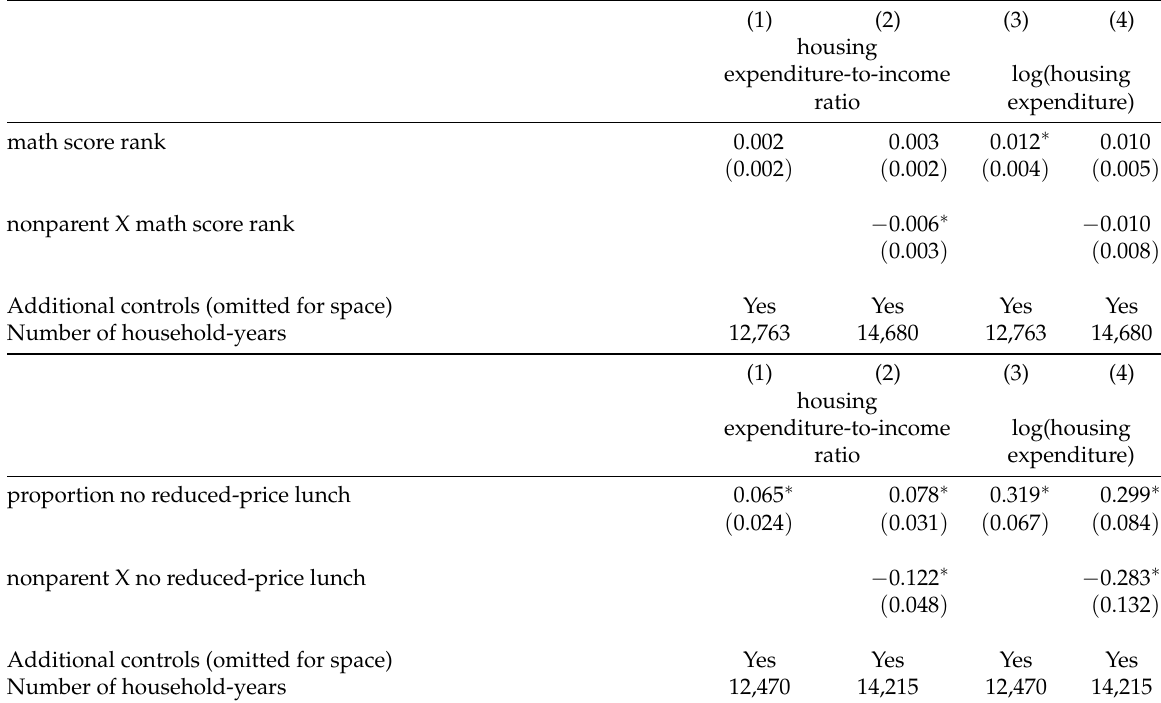
Table 2: Estimates from fixed-effects models of PSID respondents’ housing